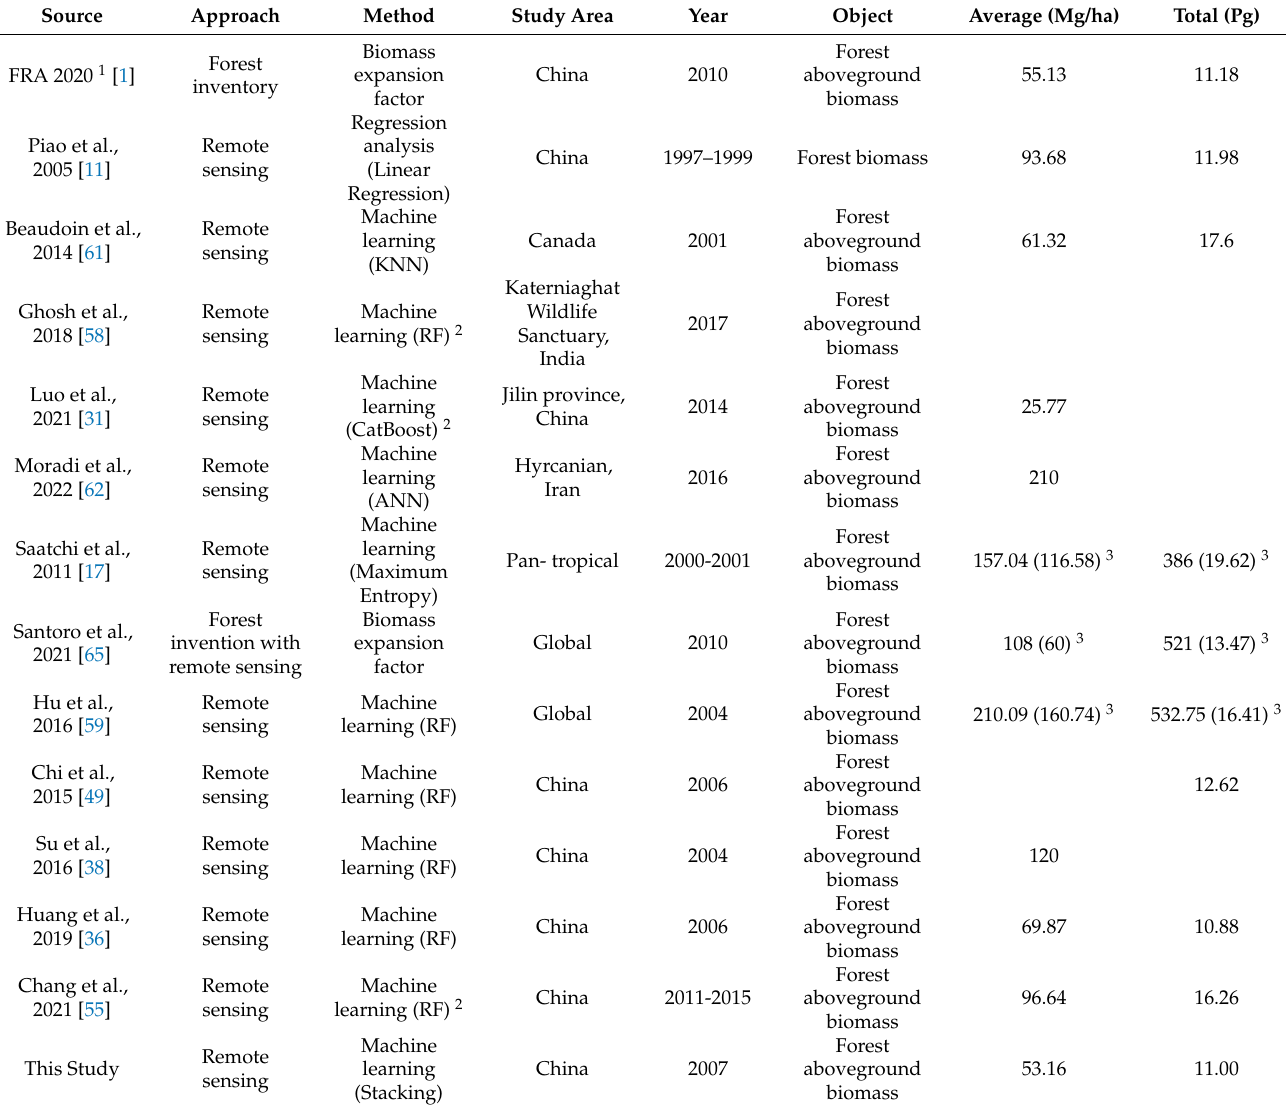
Table 7. Comparison with previous